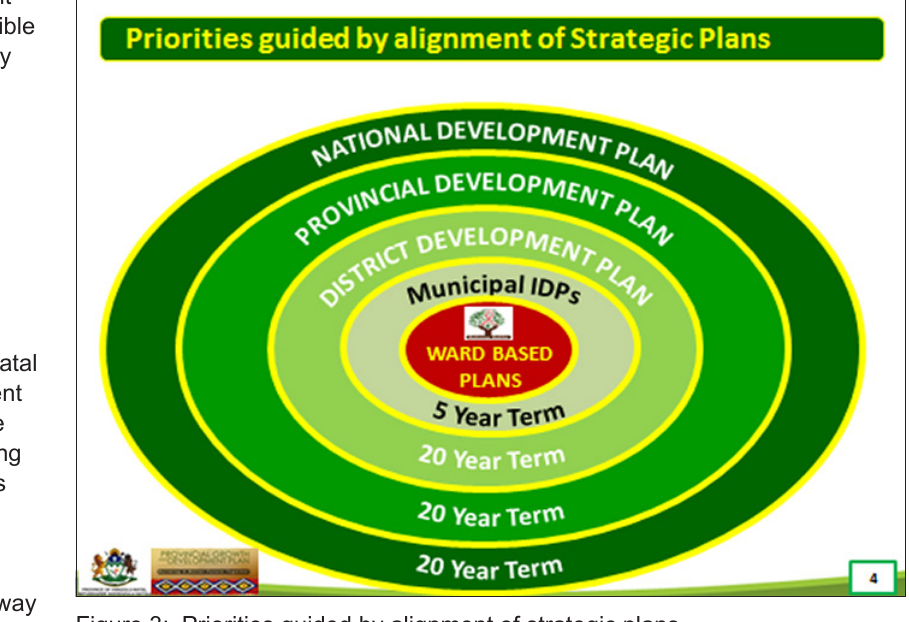
Figure 3: Priorities guided by alignment of strategic